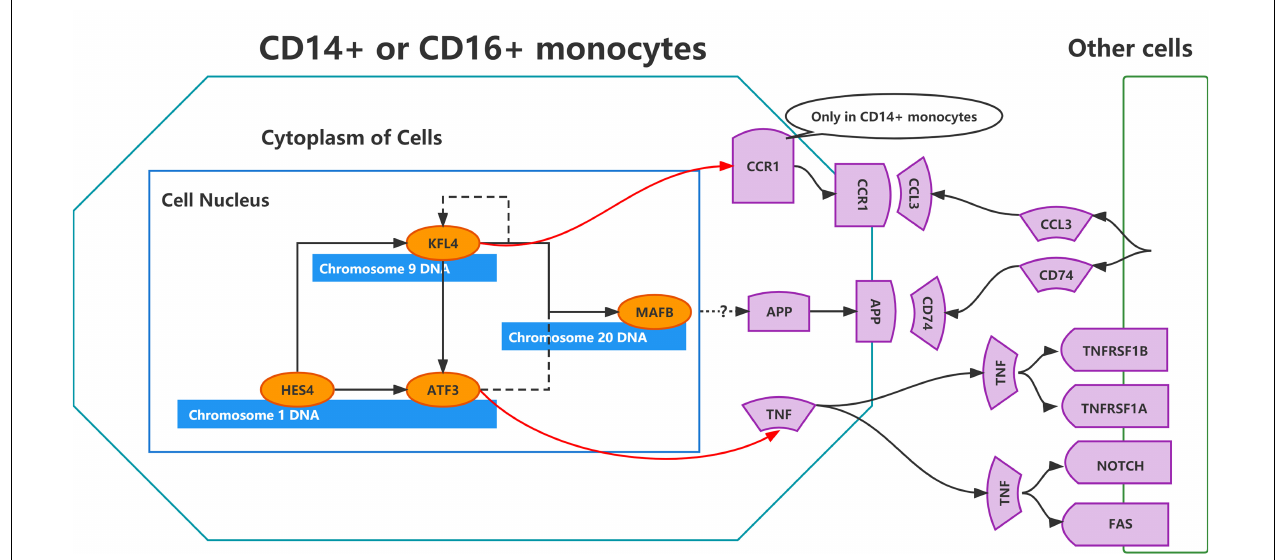
FIGURE 9 | Schematic representation of the regulatory network constructed using the ERADMT gene set.